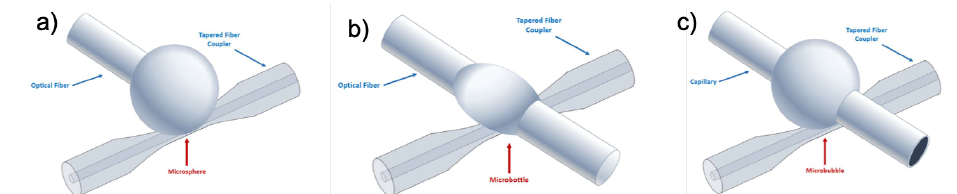
Figure 1. Schematic drawing of microspherical WGMR: ( a ) Microsphere, ( b ) Microbottle and ( c ) Microbubble. The coupling tapered fiber is also sketched in this